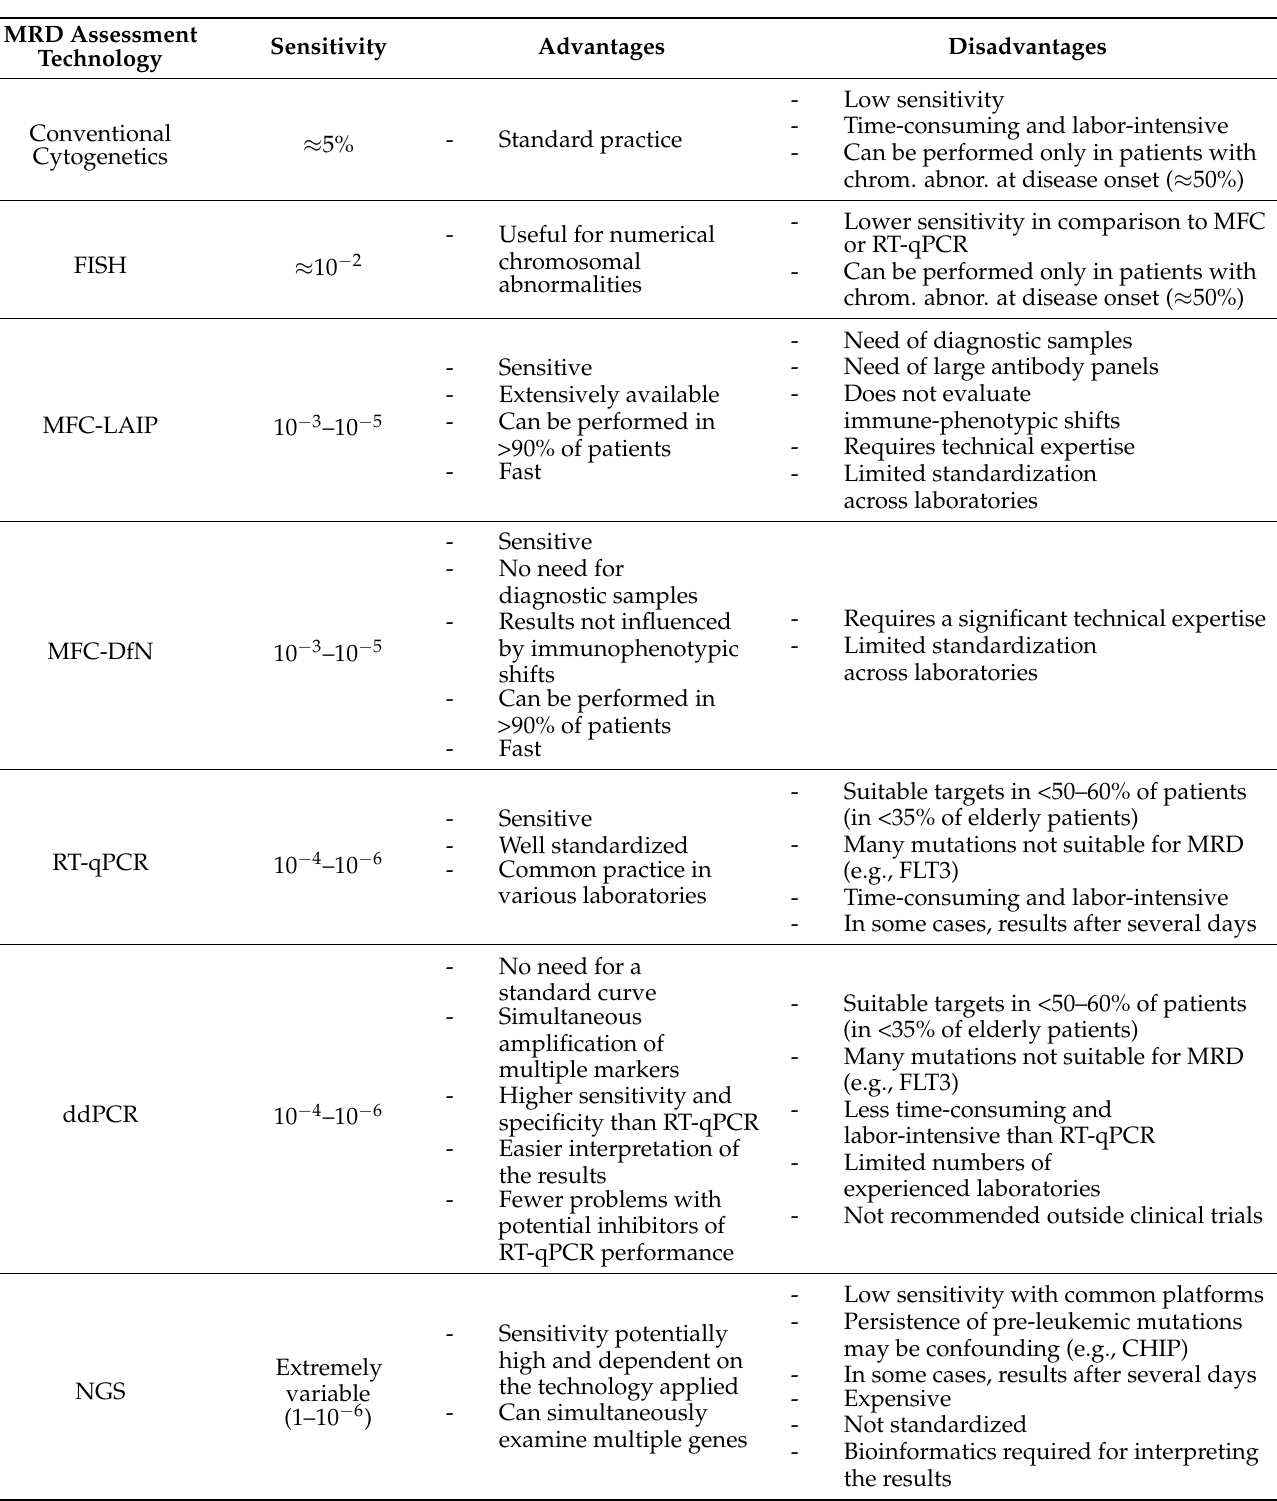
Table 1. Technologies for MRD detection in